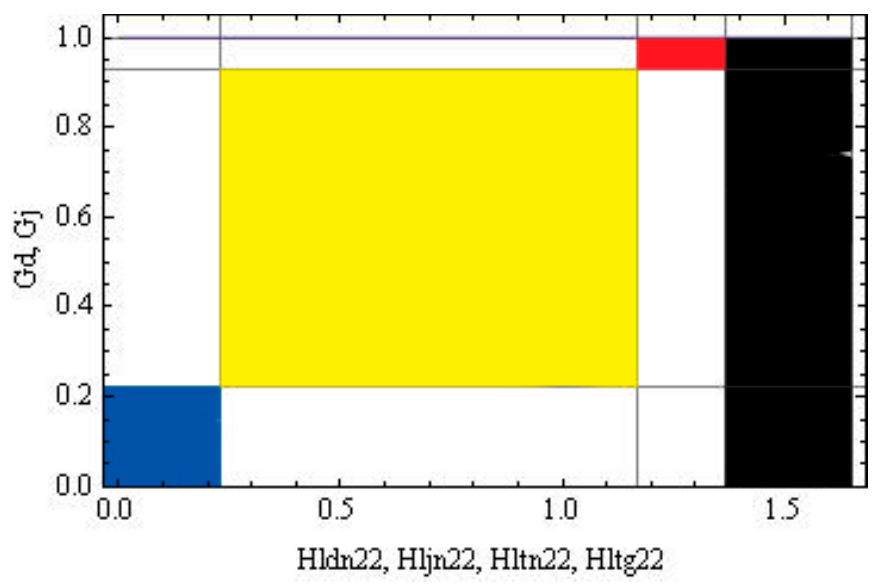
Figure A1. Characterization of a randomly chosen author for life sciences. Black area (17.1%) = networking; red area (0.9%) = intradisciplinary and intratopical heterodox; yellow area (48.7%) = intradisciplinary and intertopic orthodox; blue area (3.6%) = interdisciplinary and intertopical orthodox. G d = 0.22, G j = 0.93, H ldn = 0.23, H ljn = 1.17, H ltn = 1.37, H ltg = 1.65. Abbreviations: G d , Gini index for disciplines; G j , Gini index for journals; H , Hirsch indexes; d = discipline, g = gross, j = journal, l = linear, n = net, t = total.